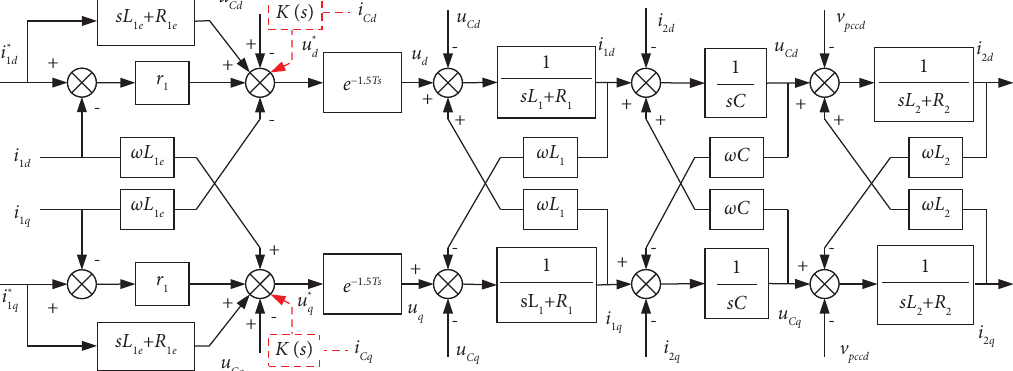
Figure 2: Control structure for LCL-fltered three-phase grid-tied VSI with EL-based PBC with inverter-side current control.